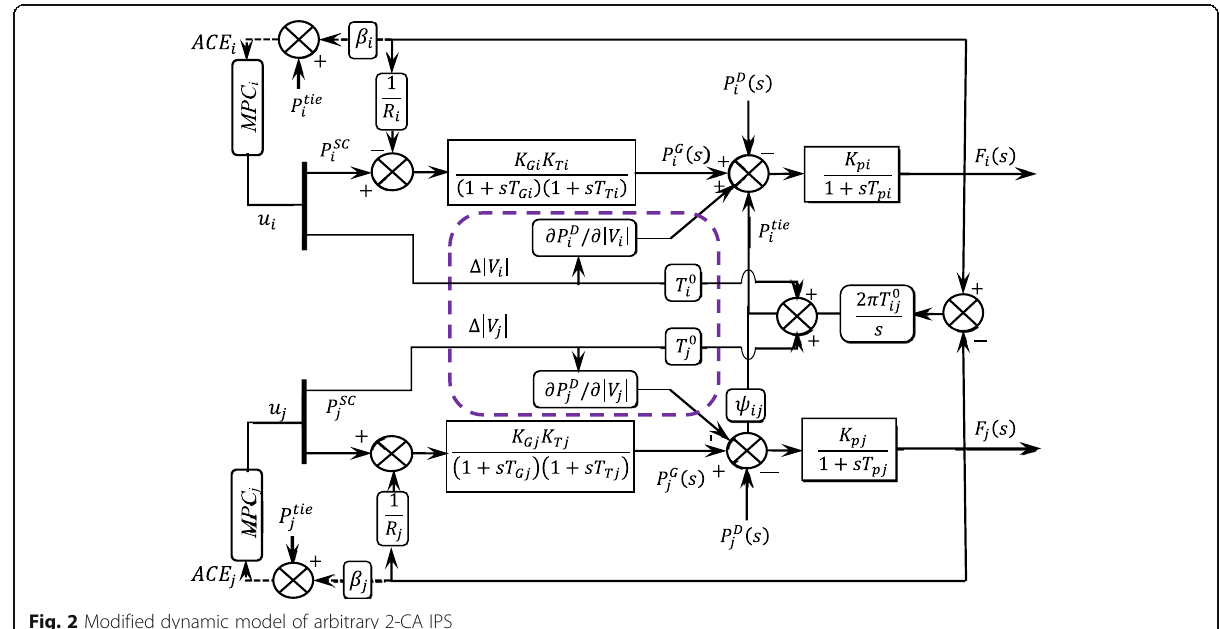
Fig. 2 Modified dynamic model of arbitrary 2-CA